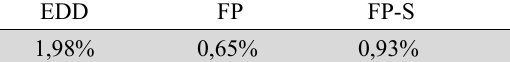
Small-sized test instances: SR